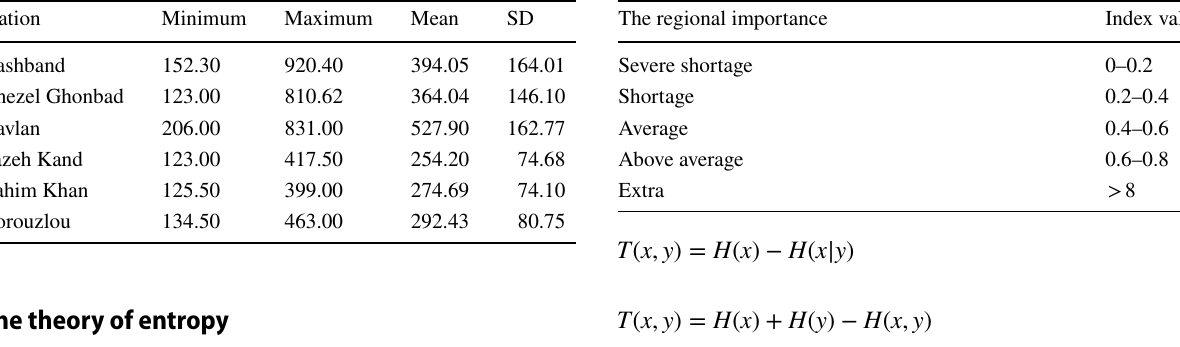
The theory of entropy